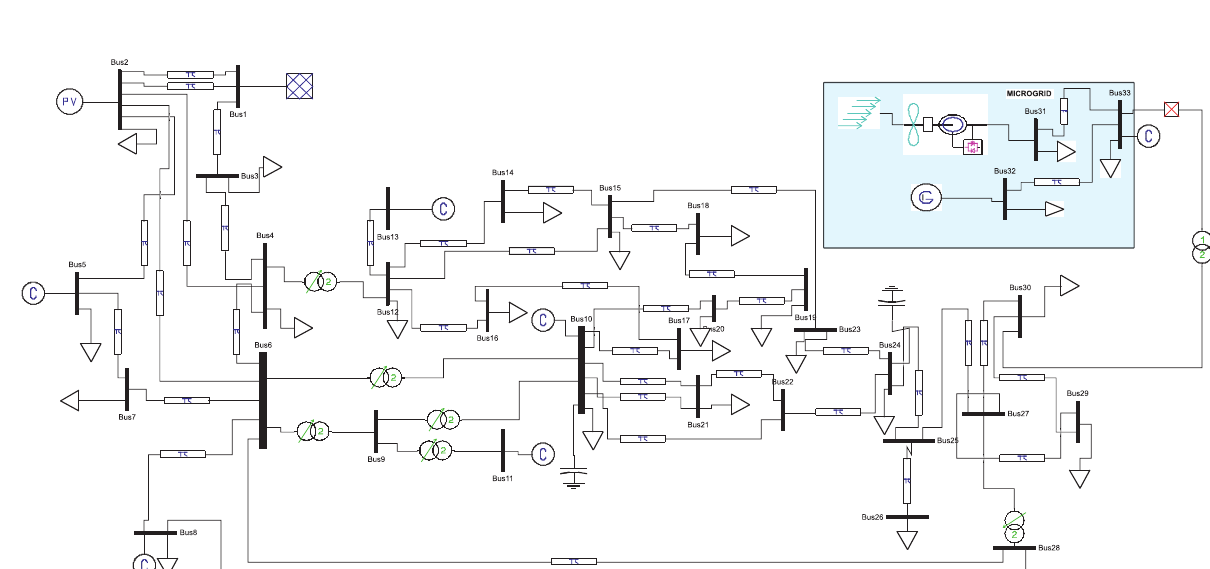
Figure 9: Integration of microgrid system in IEEE 30-bus